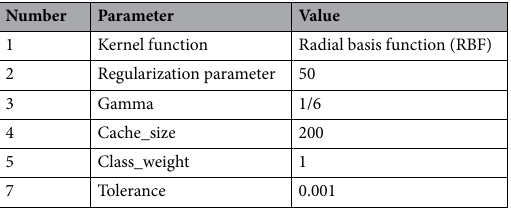
Table 2. The hyperparameters of the intelligent evaluation of the SVM model.